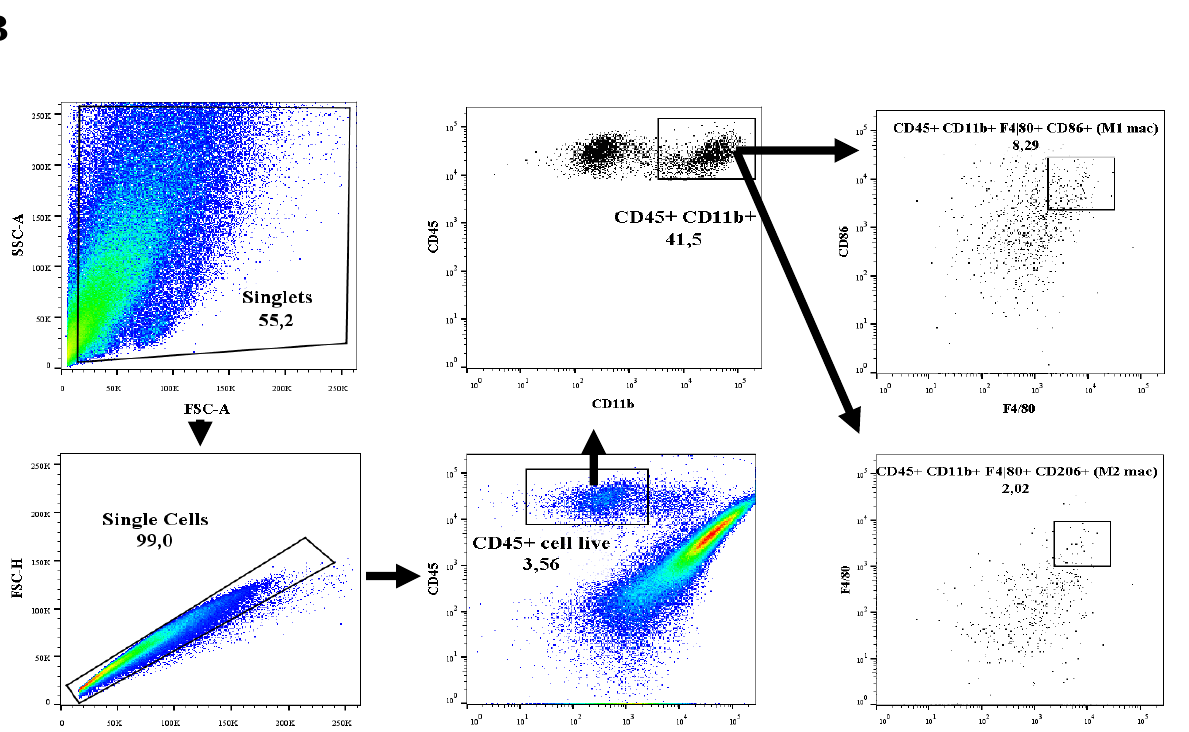
Figure 1. Gating strategy in both kidney and heart to identify populations of ( A ) leukocytes (live Figure 1. Impact of amendments on the soil properties: ( a ) pH, ( b ) EC, ( c ) OM, ( d ) NO 3 − -N, CD45+) and lymphocytes (CD45 + CD4+, CD45 + CD8+ and CD45 + CD19+) and ( B ) M1 and M2 ( e ) NH 4+ -N. Different letters above bars suggest significant differences between mean values at each macrophages. The data were extracted using the FlowJo program sampling occasion ( p < 0.05).